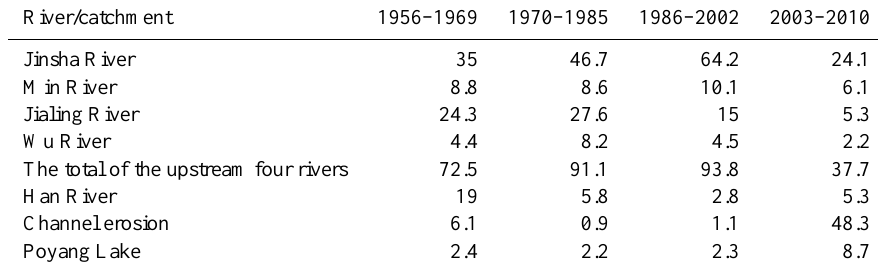
Table 2. The sediment contribution proportion (%) of different tributaries to the sediment load entering the sea of the Changjiang.